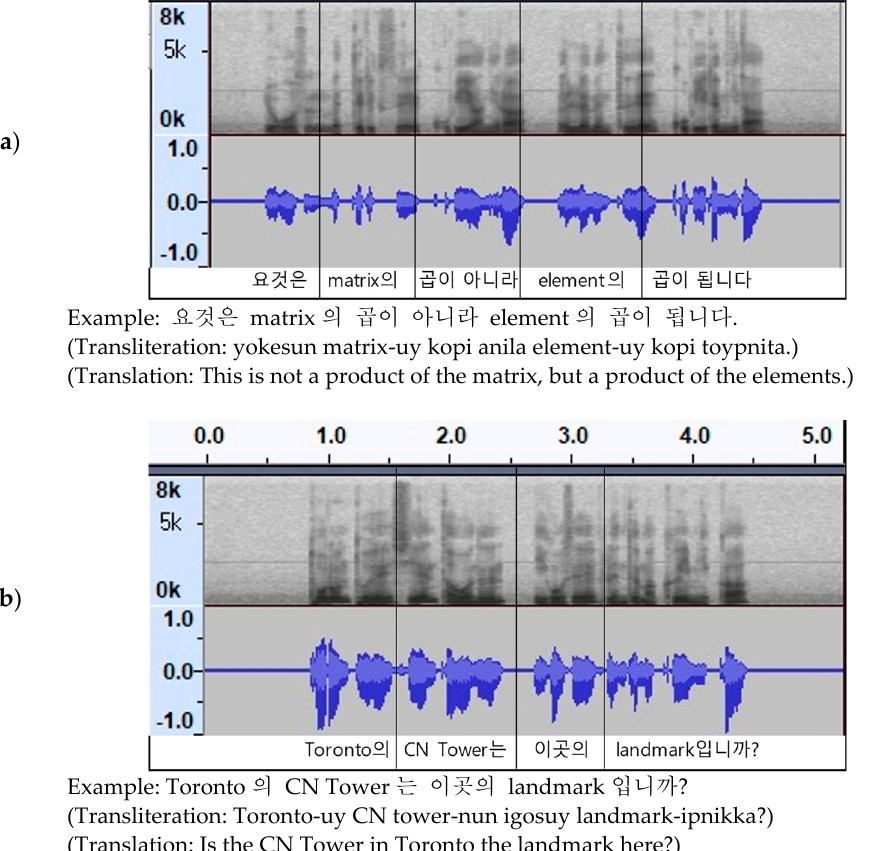
Figure 2. Typical code-switching (CS) sentences: ( a ) lecture domain ; ( b ) travel domain.